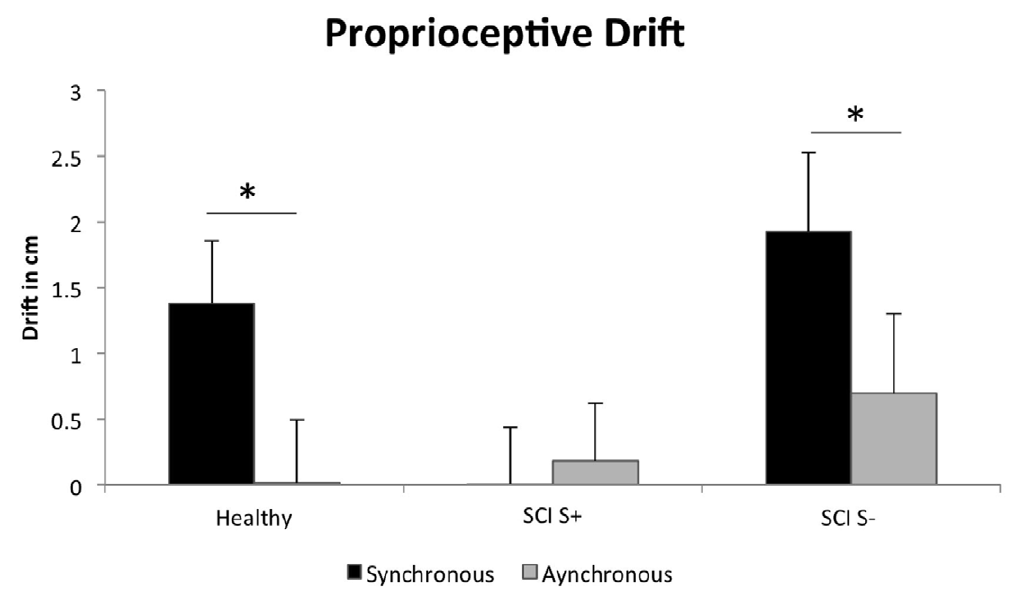
Figure 3. Significant interaction between group (SCI + , SCI-, healthy) and synchrony (synchronous, asynchronous stroking) for proprioceptive drift (mean 6 SEM). The values plotted are as compared to the baseline. * p , 0.05.